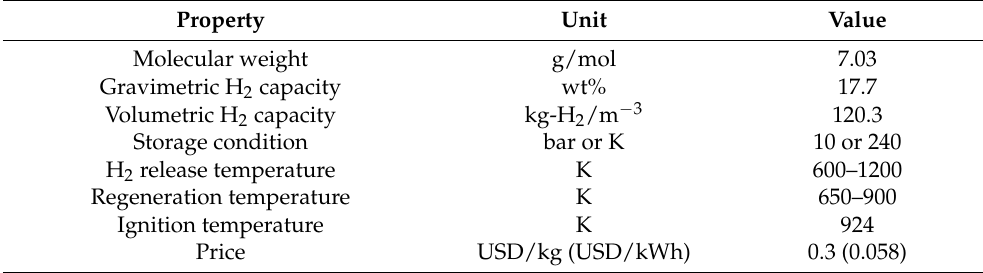
Table 7. Relevant properties of ammonia [91].